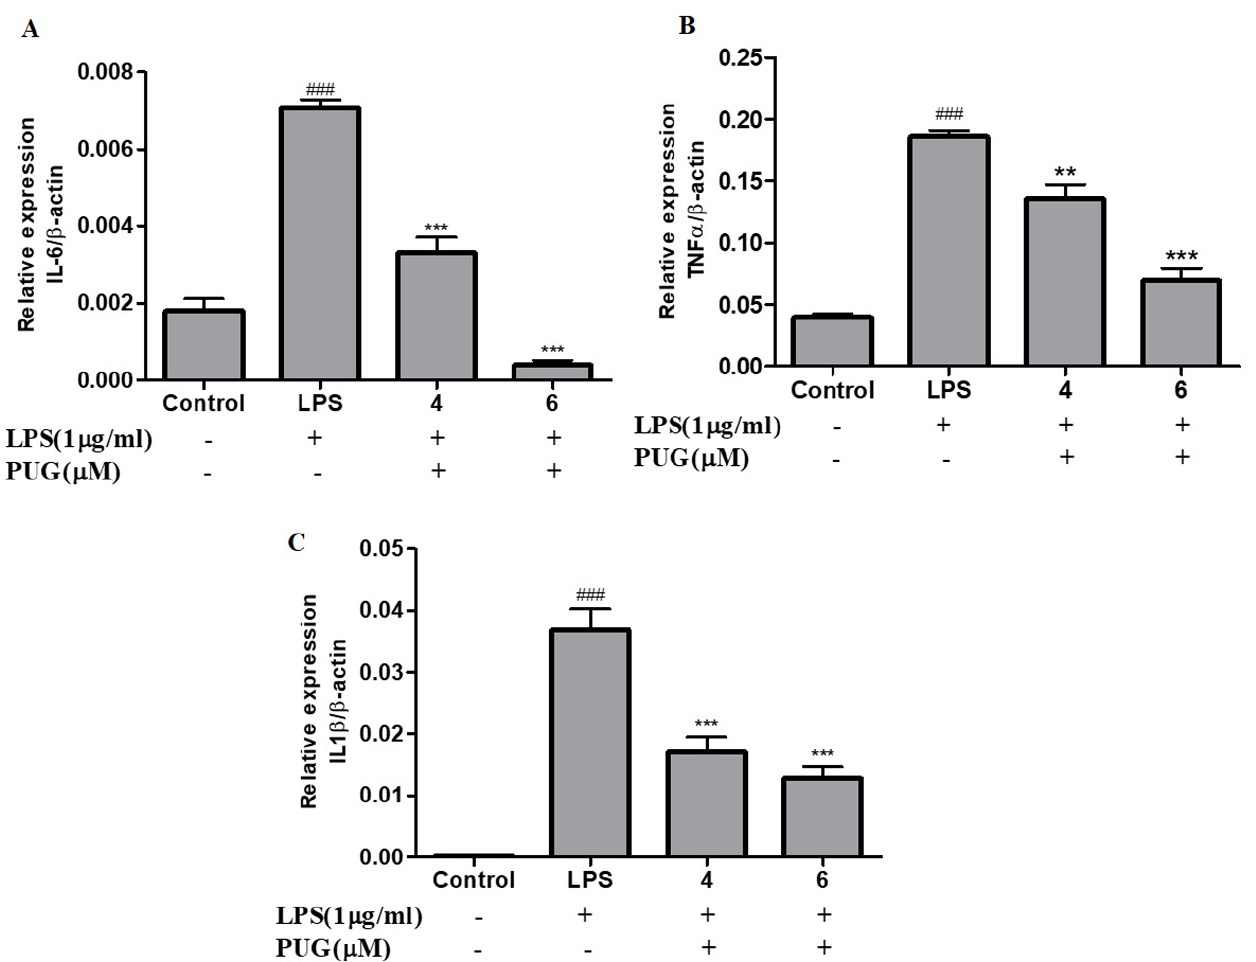
Figure 5. PUG decreases the protein expression of pro-inflammatory cytokines in activated RAW264.7 cells: The cells were treated with LPS (1 µ g/mL) and PUG (4, and 6 µ M) for 1 h and 24 h, respectively. After treatment the RNA was isolated from all the groups and converted into cDNA. Then the converted cDNA was used for qRT-PCR with the kit components. The graph was plotted using C q values by the 2 − ∆∆ Cq method. The relative expression of each gene was calculated by normalizing with the β -Actin gene. ( A ) Relative expression of IL-6. ( B ) Relative expression of TNF α . ( C ) Relative expression of IL-1 β . The statistical significance was ### p < 0.001 vs. untreated group; and ** p < 0.01, *** p < 0.001 vs. LPS-alone treated group.